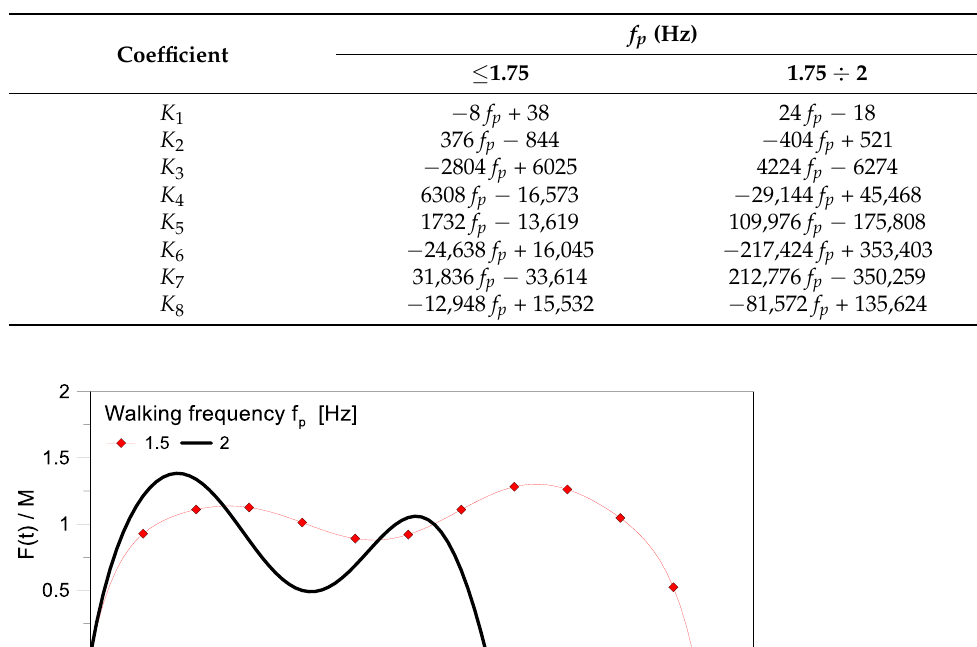
Table 2. Definition of input coefficients K i for Equation (14), based on walking frequency f p .